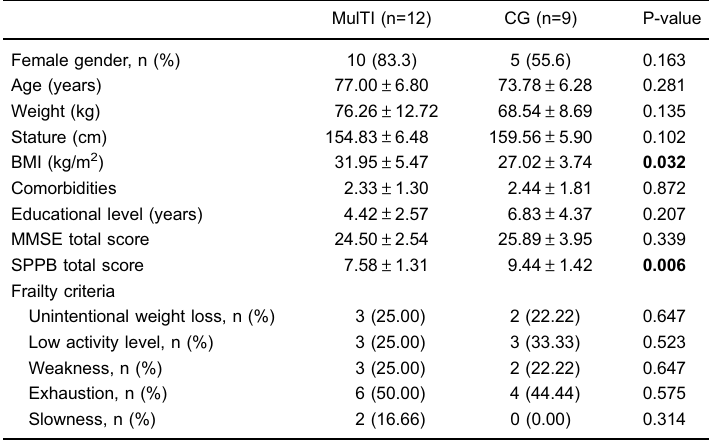
Table 1. Age, anthropometric, and clinical